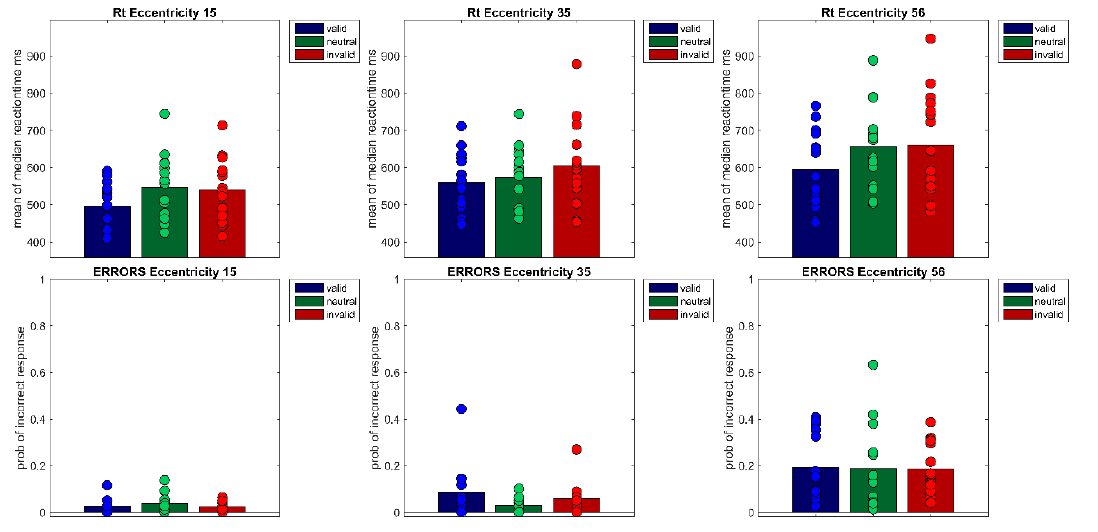
Figure 5. The figure shows the correct reaction times of Experiment 2 per Eccentricity (15°, 35°, 56°) × Cueing (valid, neutral, invalid). Bars show the mean of median reaction times across participants. Filled circles show the medians of each individual participant (upper row). The lower row shows the probabilities of incorrect responses for each of the nine conditions. Bars denote the mean probability across participants, filled circles the probabilities of each participant.